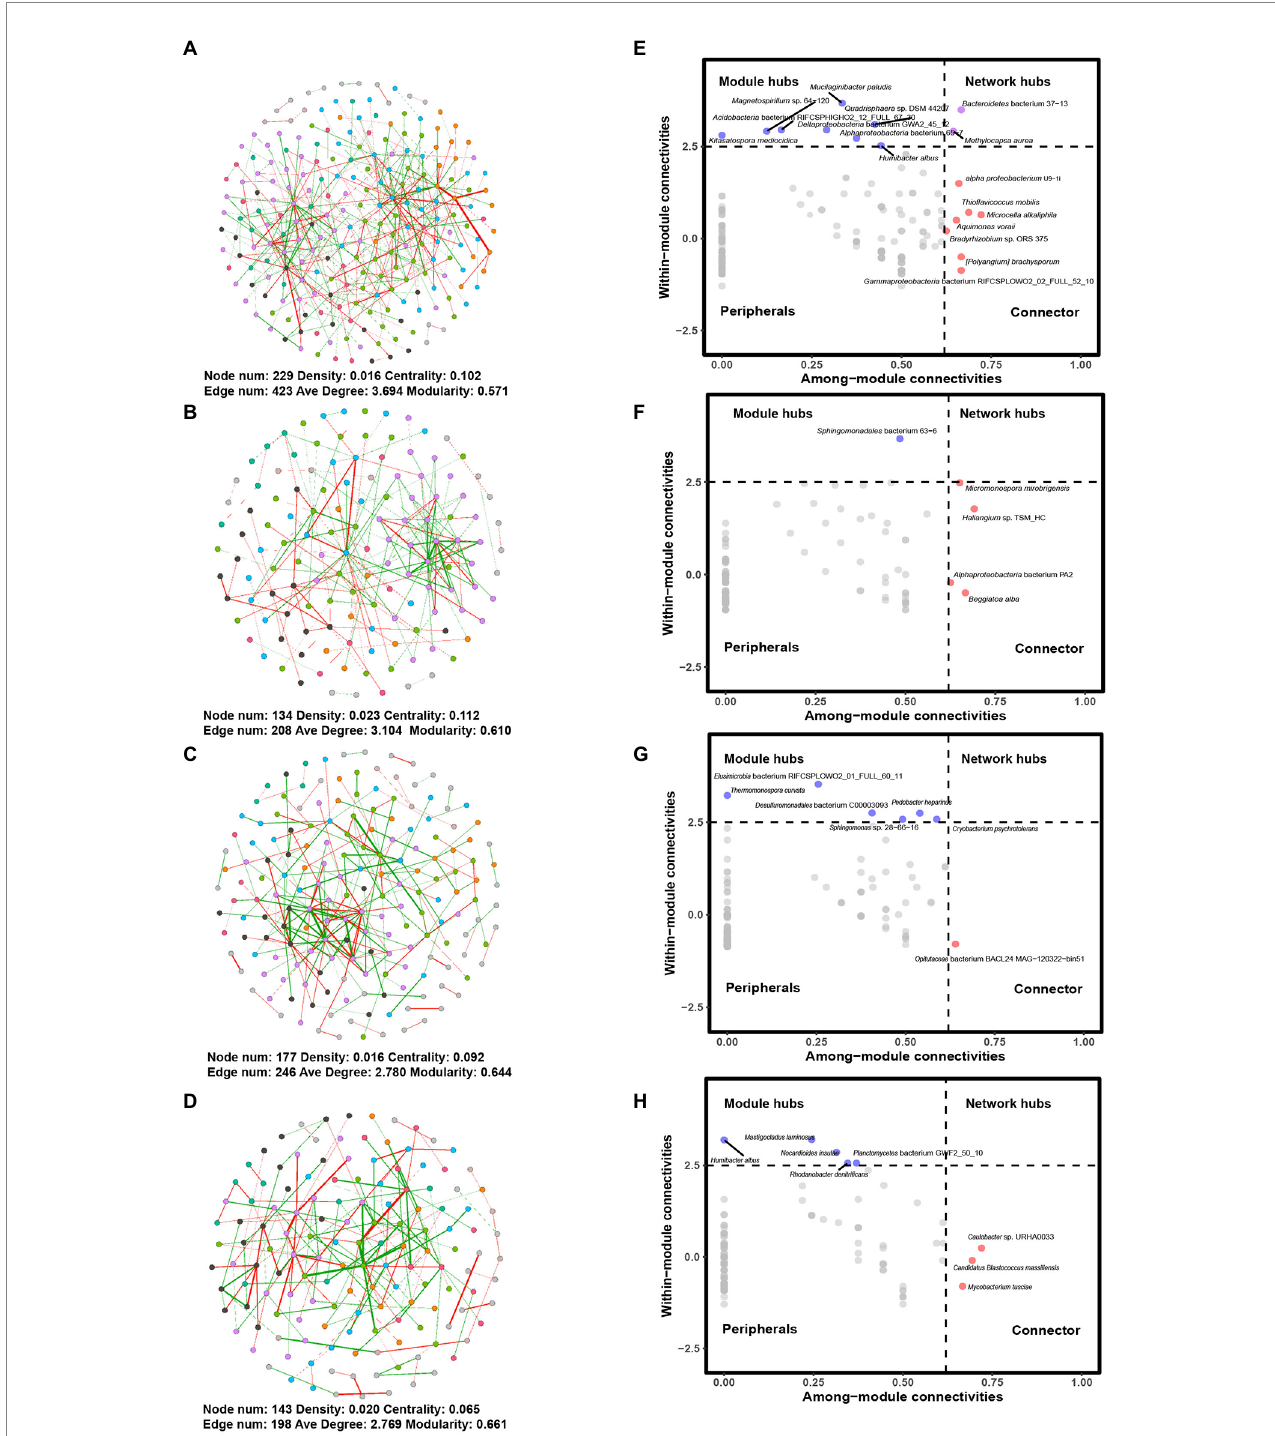
FIGURE 4 Networks and Z i -P i plots for different groups. Networks for (A) G1, (B) G2, (C) G3, and (D) G4 and Z i -P i plots for (E) G1, (F) G2, (G) G3, and (H) G4. The colors of nodes indicate network modules. Edges in red and green refer to positive and negative correlations, respectively. G1, 101-14 treated with NaCl; G2, 101- 14 treated with ddH 2 O; G3, 5BB treated with NaCl; G4, 5BB treated with ddH 2